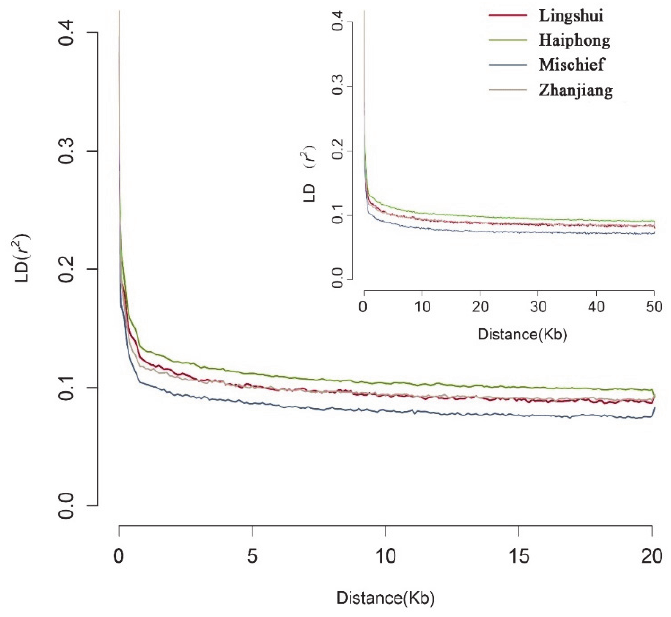
Figure 4. Linkage ‐ disequilibrium decay for different distances of the four populations. Figure 4. Linkage-disequilibrium decay for different distances of the four